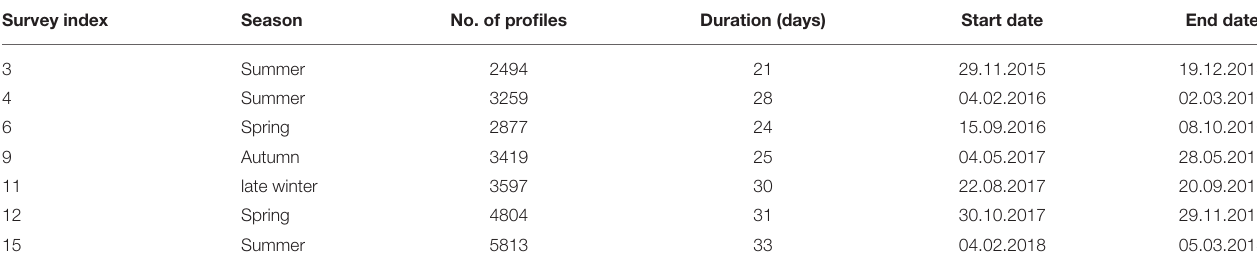
TABLE 1 | Glider survey index, seasonal affiliation, number of profiles sampled, start and end dates of each glider survey completed in Greater Cook Strait. Survey